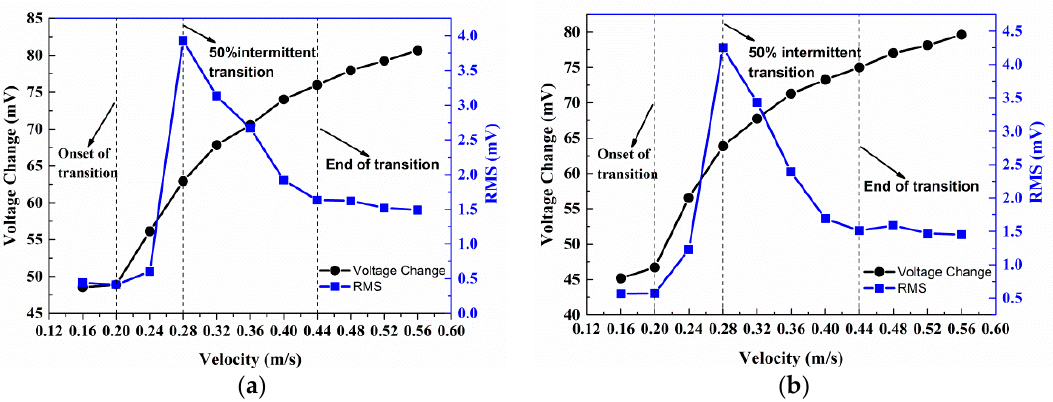
Figure 12. Voltage changes and RMS values of ( a ) sensor 2 and ( b ) sensor 8.